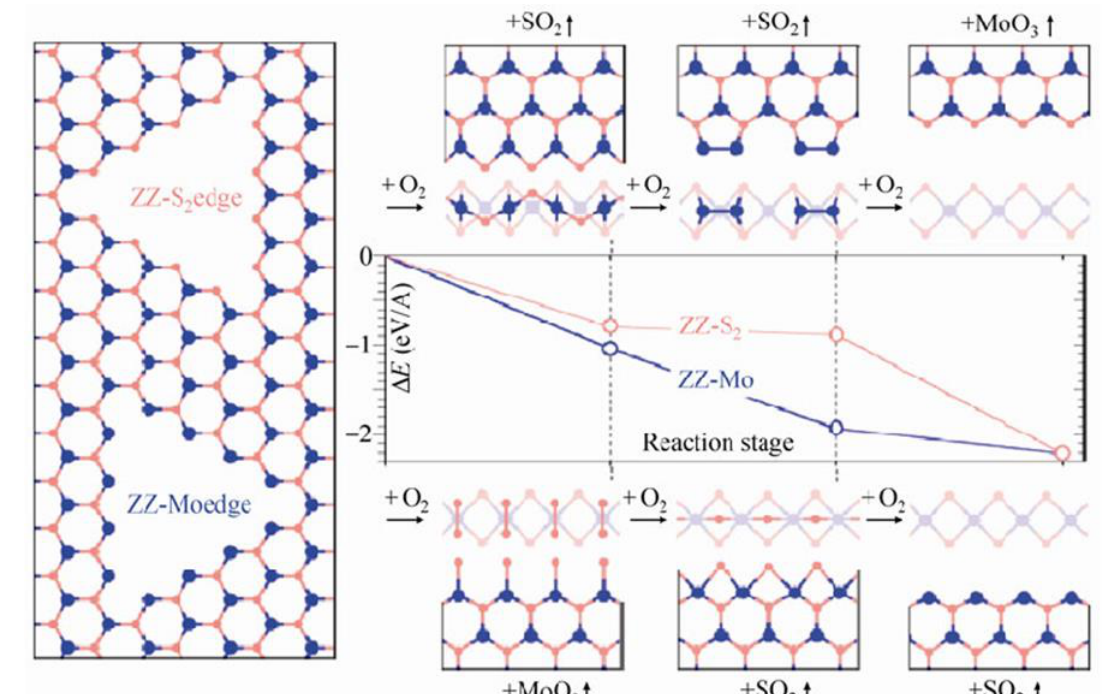
Figure 17. Oxidative etching according to Zhou et al. [33]. An atomic mechanism showing the formation of triangular pits in MoS 2 layers. A pit in MoS 2 could generally expose various types of edges, including ZZ-Mo and ZZ-S 2 , as shown on the left. The Mo and S atoms are represented by large (blue) and small (red) circles, respectively. Right: The atomic edge structures (top and side views) during oxidation of ZZ-Mo are shown in the bottom panels, and those for ZZ-S 2 are displayed in the top panels. ∆ E is defined as the enthalpy change (normalized by the edge length) from one edge structure to another, by incorporating O 2 and evaporating MoO 3 or SO 2 gas molecules. Starting from the ZZ-Mo edge (bottom panel), the oxygen reacts first with Mo and then S, while for ZZ-S 2 , the reaction is in the reverse order. Notably, significant structural reconstructions are found in both cases. During the etching of ZZ-Mo, the energy drops monotonically, while for ZZ-S 2 , there is a plateau, suggesting that the ZZ-S 2 edge probably propagates more slowly than in the ZZ-Mo edge, and thus appears at the etched pit. Reprinted by permission from Springer Nature Customer Service Centre GmbH: Springer Nature, Nano Research [33]